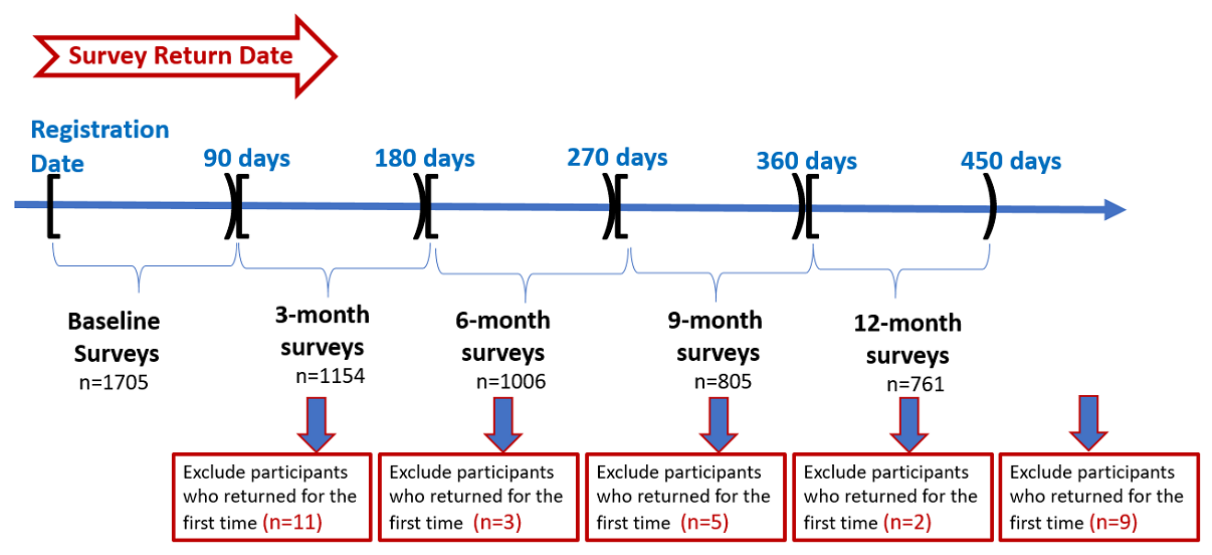
Figure 1. The time window approach for separating baseline and other follow-up surveys (here, completing a survey means completing 75% of questions in the given